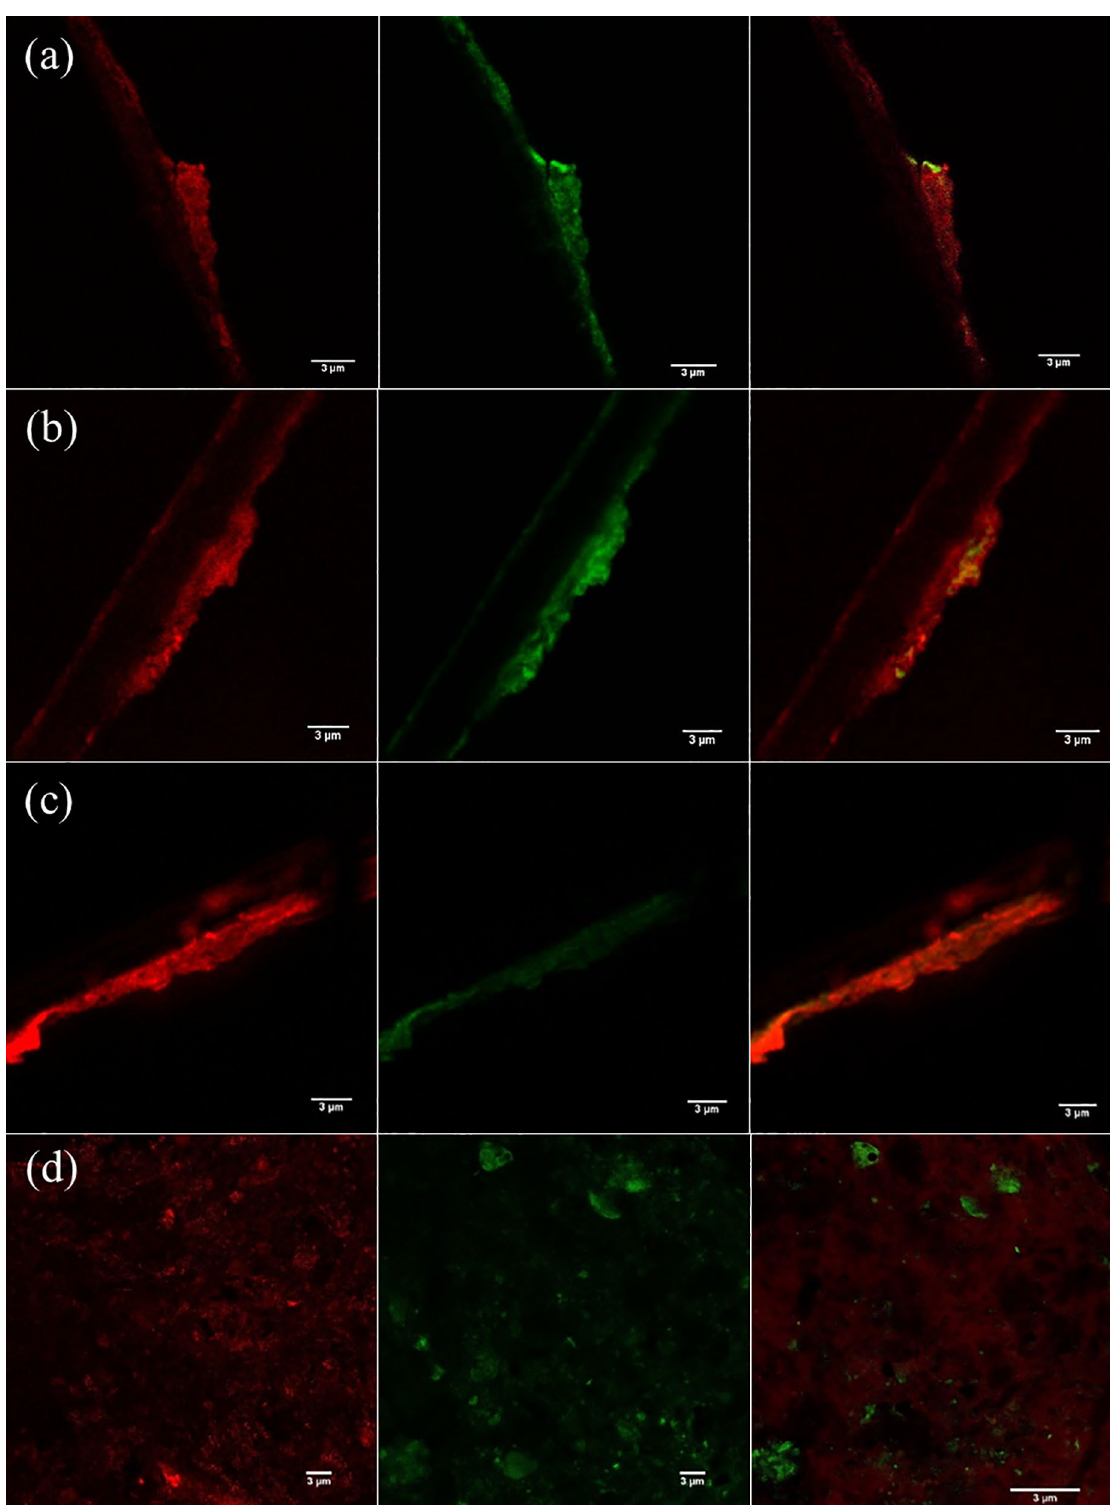
Figure 3. Representative confocal microscopic images of EPS with 3 µm scale; anode (CF–CF) ( a ), cathode (CF–CF) ( b ), anode (CF–SS) ( c ), and cathode (CF–SS) ( d ). The green color represents eDNA and the red color indicates EPS (This figure has been analyzed using COMSTAT2, Version 2.1, Dk, http:// www. comst at.